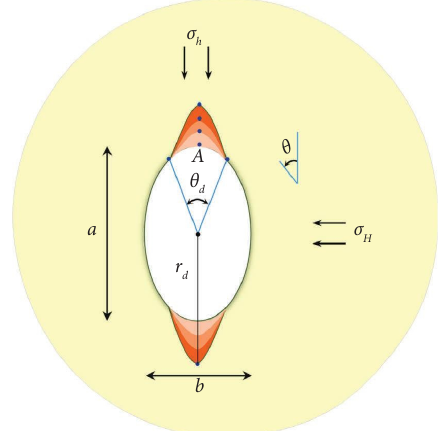
Figure 1: Elliptical borehole and shear failure around